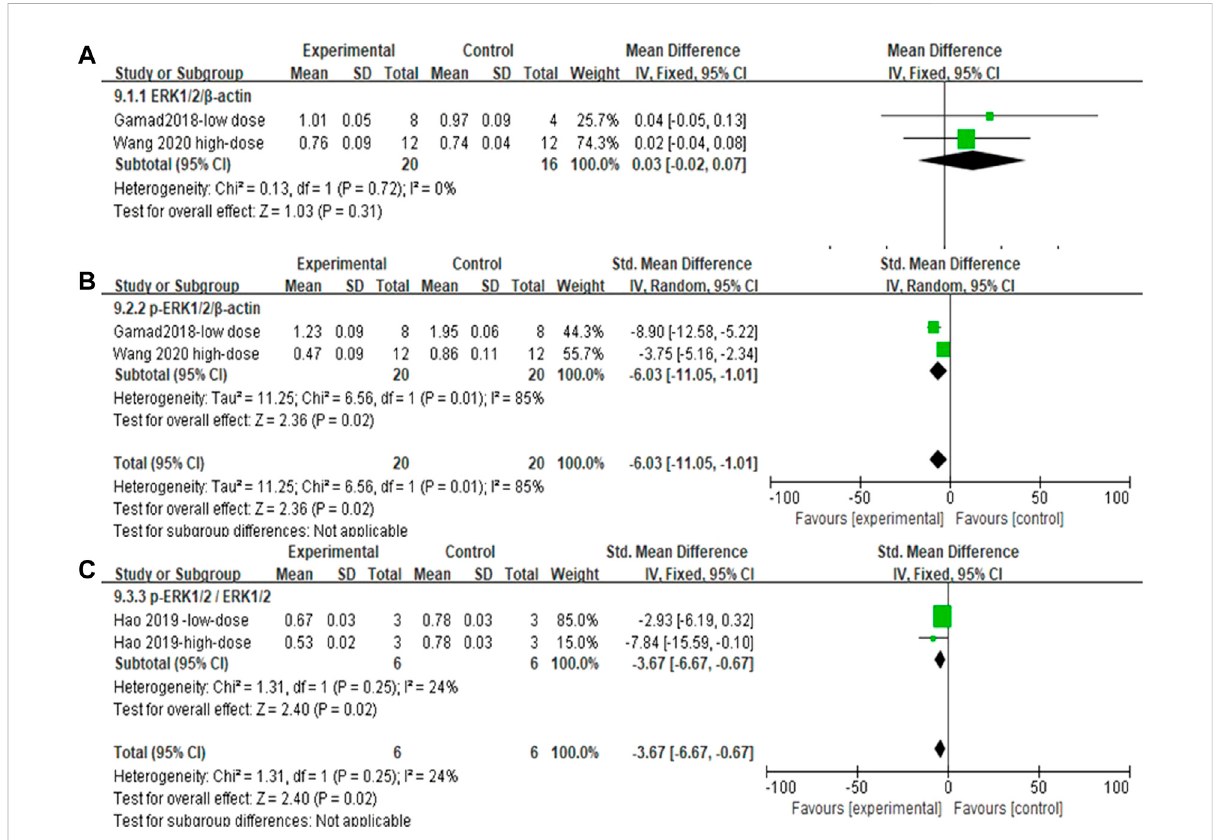
FIGURE 12 Effect of MET on ERK1/2 phosphorylation levels in lung tissues of PF animals. (A) Forest plot of ERK1/2; (B) Forest plot of ERK1/2p-ERK1/2; (C) Forest plot of ERK1/2p-ERK1/2/ERK1/2.